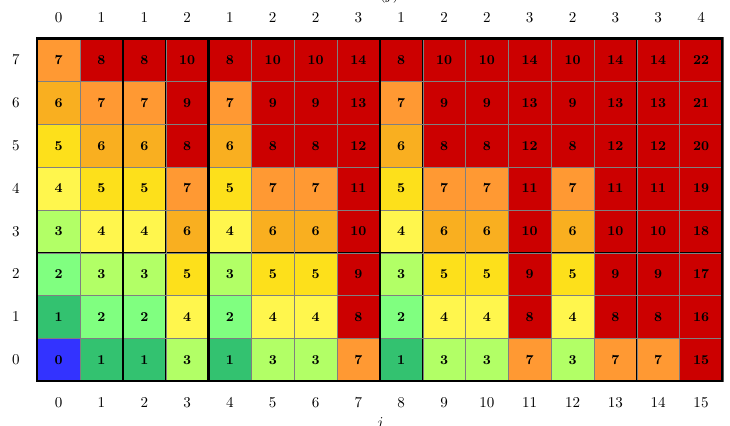
Figure 3. Smallest possible candidate indices m (cid:48) and list index l